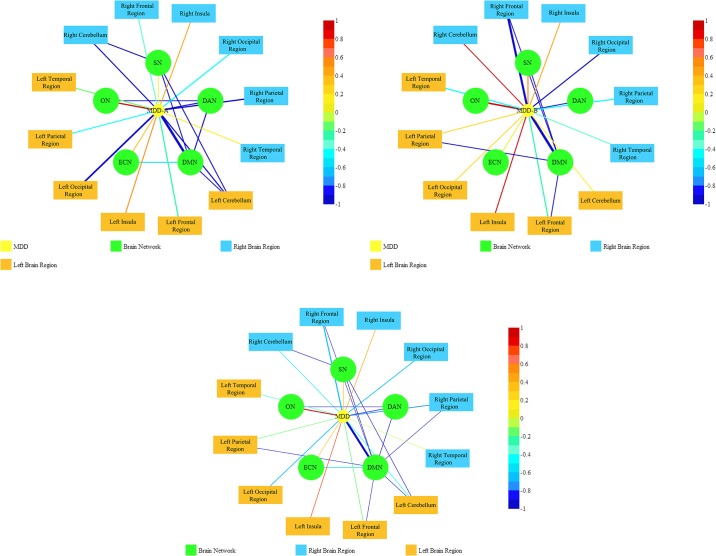
The Probabilistic Entity-Relationship Diagram of MDD.Each point refers to the rs-FC of the brain and the color of each point refers to different categories. Edge widths refer to the degree of consensus on a certain correlation and the color of edge widths refer to the sign and strength of the correlation. (a) The PERD of MDD-A represent rest-stating functional connectivity. (b) The PERD of MDD-B represent spontaneous brain activity. (c) The PERD of MDD represent a combination of them.